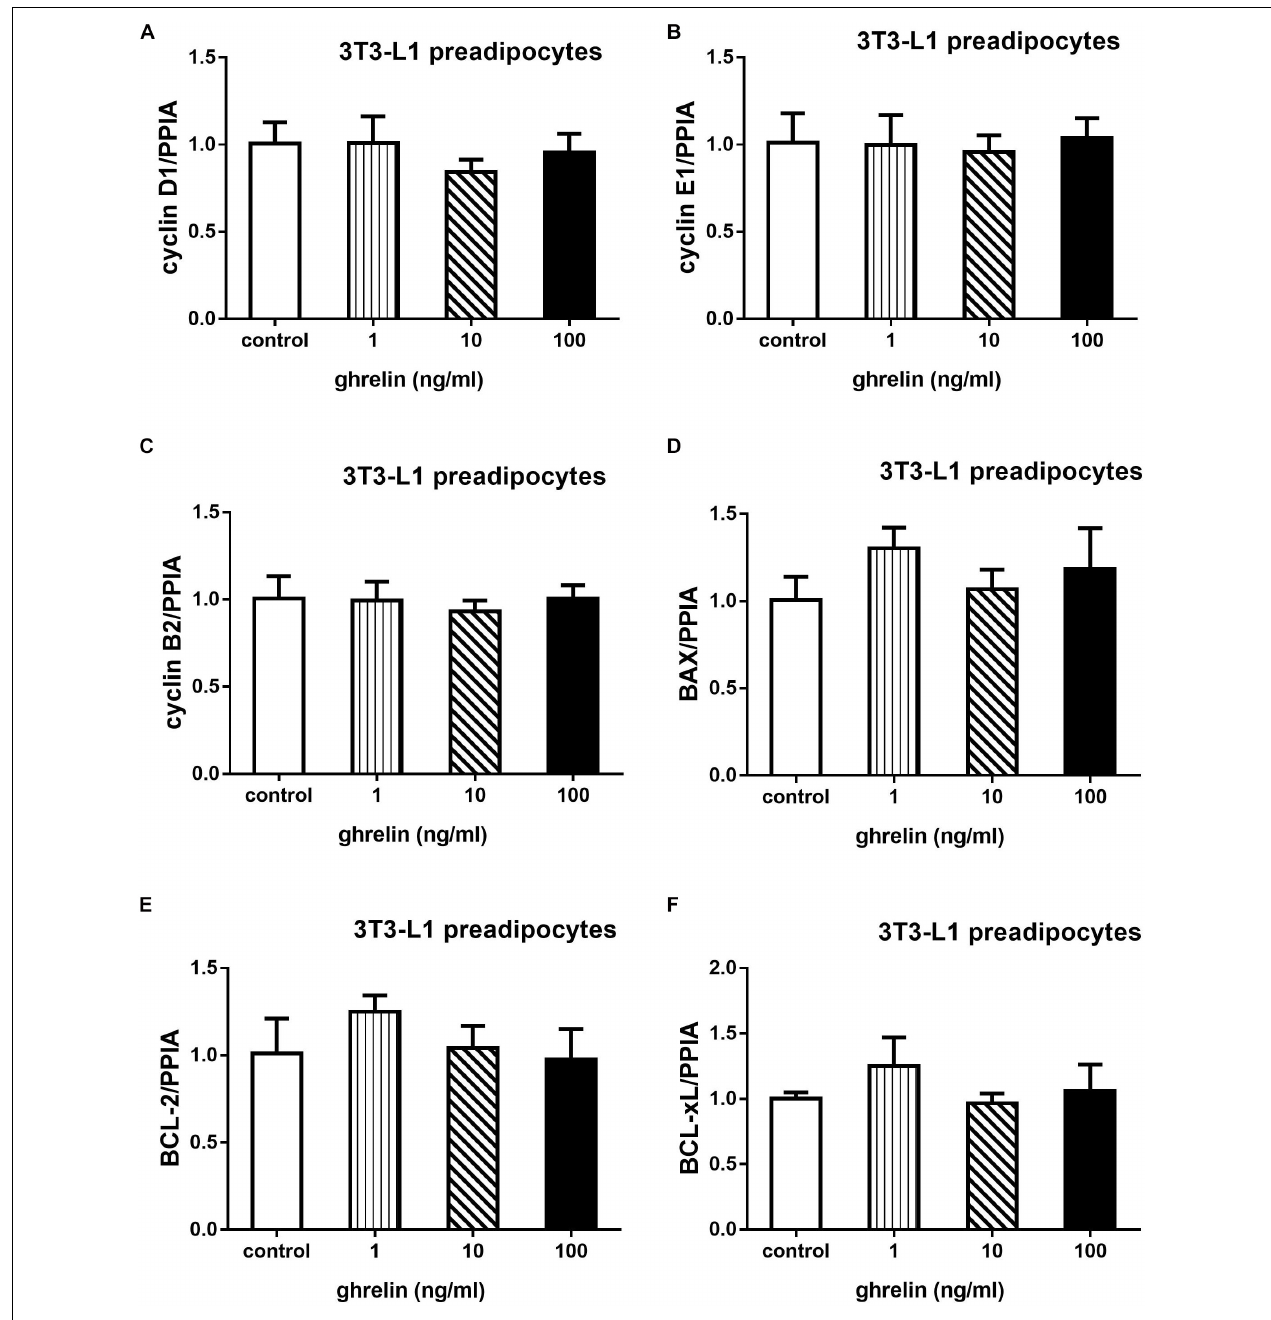
FIGURE 4 | Effects of ghrelin on proliferation and apoptosis-related genes expression in 3T3-L1 preadipocytes. The mRNA levels of cyclin D1, E1, B2, and apoptosis genes BAX, Bcl-2, Bcl-xL were determined by RT-qPCR analysis (A–F) . The data are presented as the mean ± SD for three independent experiments with three wells in each experiment. ∗ p < 0.05 vs. 0 ng/ml ghrelin